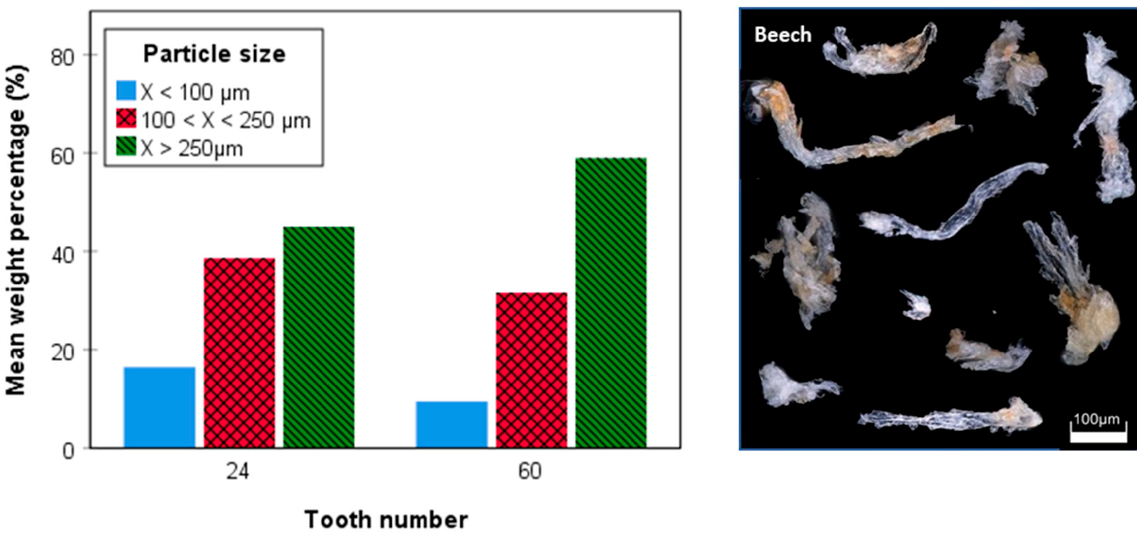
Figure 5. Particle size proportion of tooth number 24 and 60 for beech wood showing a significant difference ( t -test, p < 0.05, n = 4; ( left )); microscopic picture of the produced dust particles ( right ).